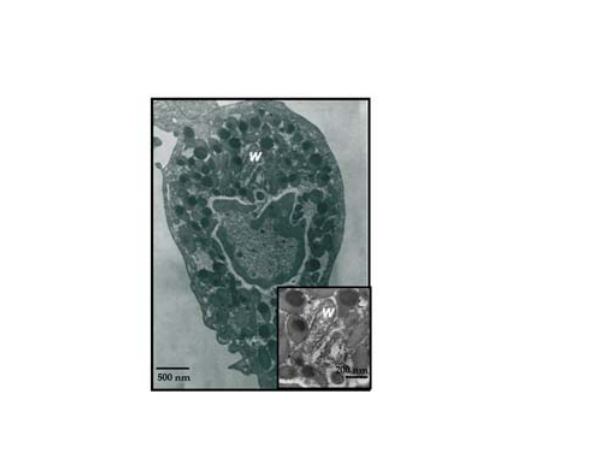
Figure 2. Haemocyte from an A.vulgare female infected with w VulC observed by transmission electronic microscopy. Hae- mocytes were included in agar gel and cut. Thick sections (0.5 m m) were stained and observed using a transmission electronic microscope. Wol- bachia (notated w on the photography) cells were observed by transmission electronic microscopy in haemocytes of all C and M females tested.